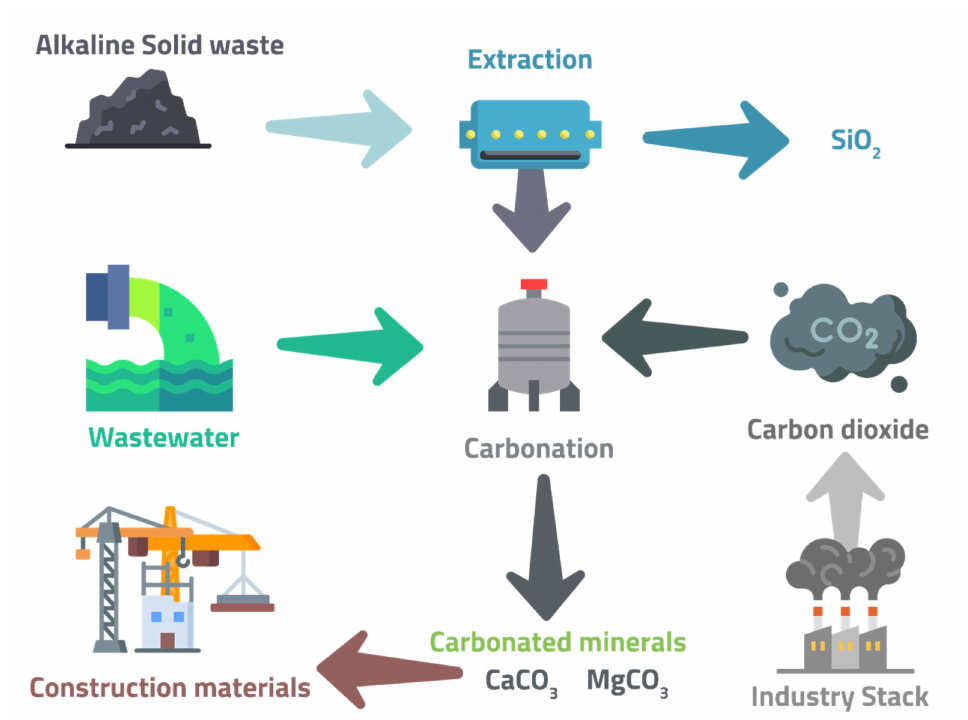
Figure 7. Ex situ indirect carbonation (multi-step carbonation), adapted from Pan et al.